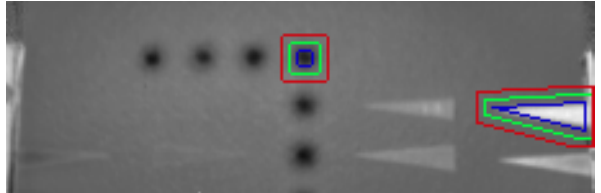
Figure 5. Examples of reference and defect regions. The boundaries of the reference region are between the green and red lines, while the defective region is inside the blue line area.